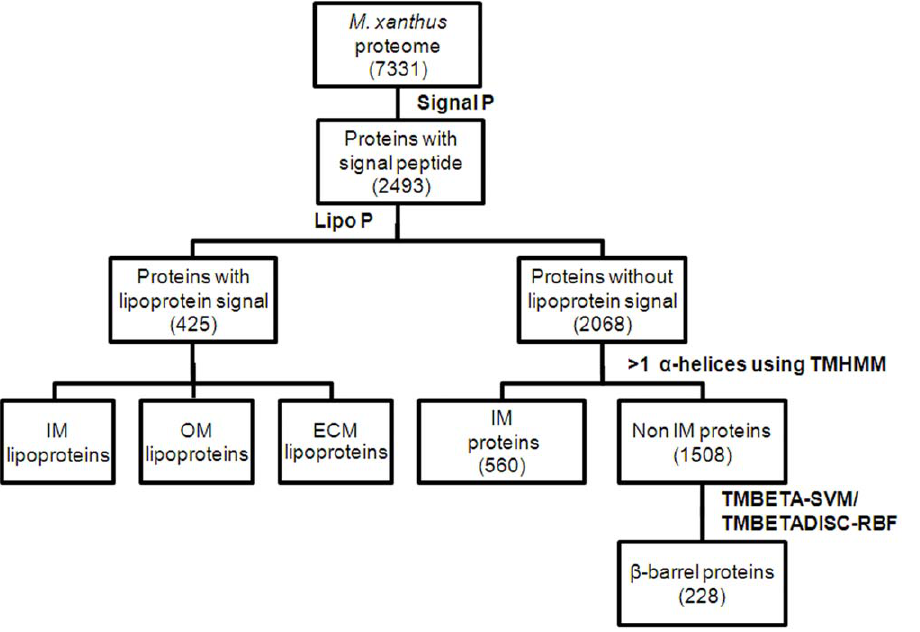
Figure 1. Scheme to identify OM proteins utilizing bioinformatic programs. The Signal P program identified 2493 signal peptide containing proteins among the putative 7331 member M. xanthus proteome. Of these 425 lipoproteins were identified using Lipo P. Of the 2068 proteins without a lipoprotein signal 560 were integral IM proteins identified using TMHMM. The non-IM proteins include periplasmic proteins, secreted proteins and OM proteins. Finally, integral OM proteins containing a b -barrel domain were identified using TMBETA-SVM plus TMBETADISC-RBF.